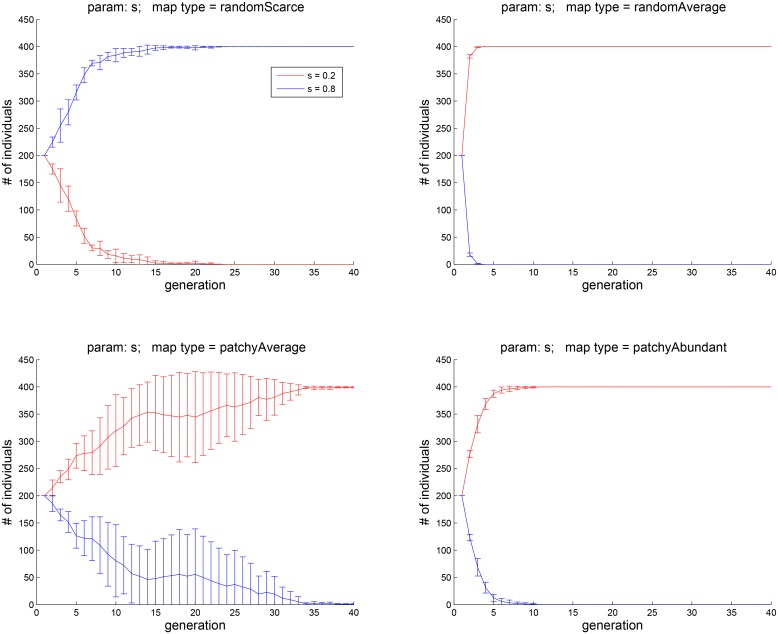
Experiment 3B: subpopulations with two values of s, 0.2 and 0.8, were pitched against each other.The higher value of s, corresponding to social comparison contributing more towards H, appears to be advantageous only in the scarce-food environment. The lower value of s is more advantageous when food is average or abundant.